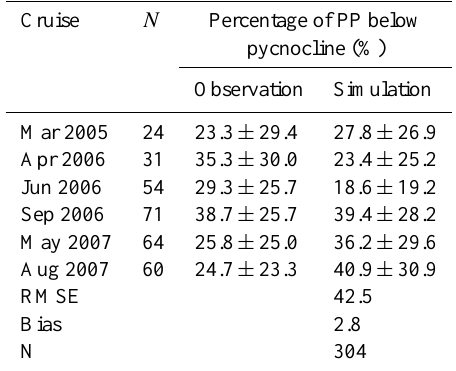
Figure 7. Model-simulated sediment oxygen consumption (SOC) versus bottom dissolved oxygen (DO) for the period 2004 to 2007, including the median (solid line) and the range between 25th and 75th percentiles (shaded area). Also shown for comparison are ob- servations from Rowe et al. (2002), McCarthy (2013), Lehrter et al. (2012), and Murrell and Lehrter (2011). Table 4. Shelf-wide average observed and simulated percentage of primary production below the pycnocline (mean ± standard devia- tion). N is the number of